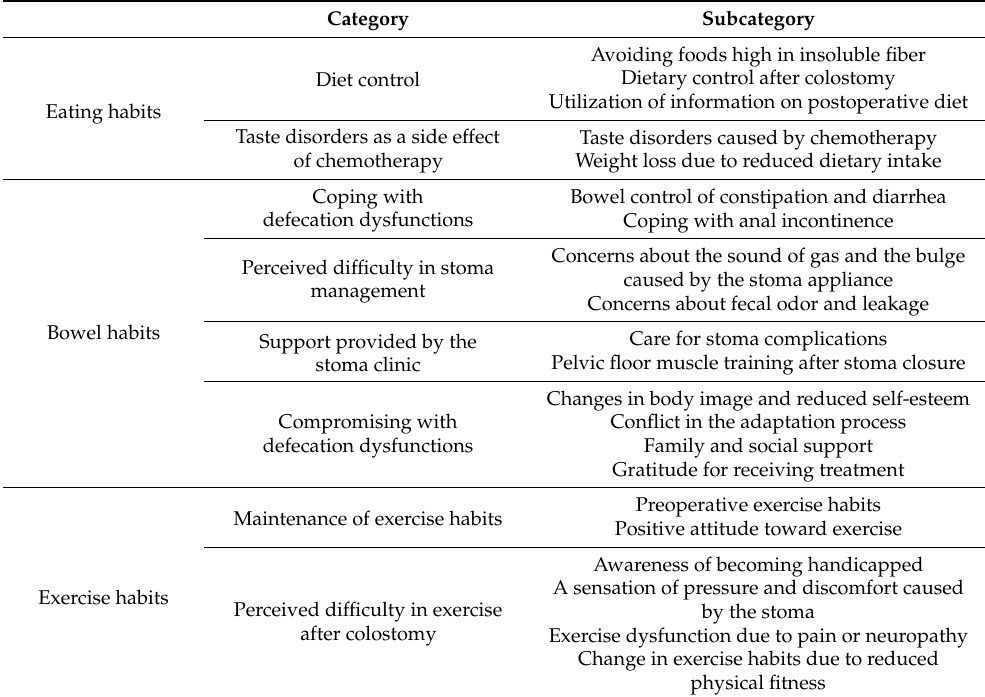
Table 5. Categories of lifestyle impacts in the stoma